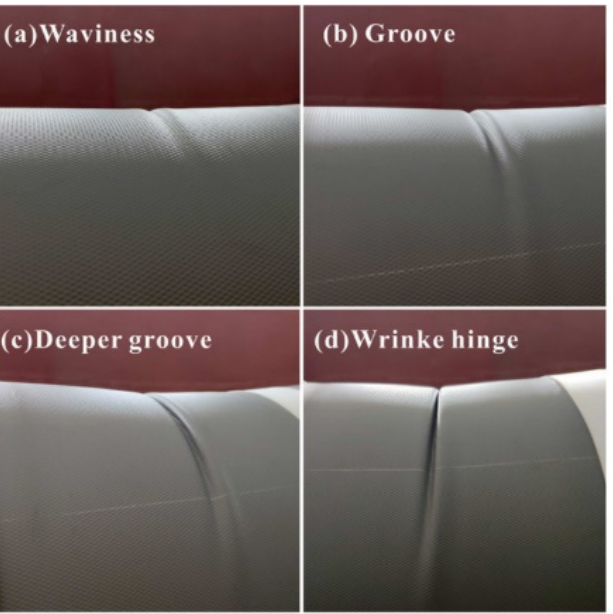
Figure 16. Development of wrinkles